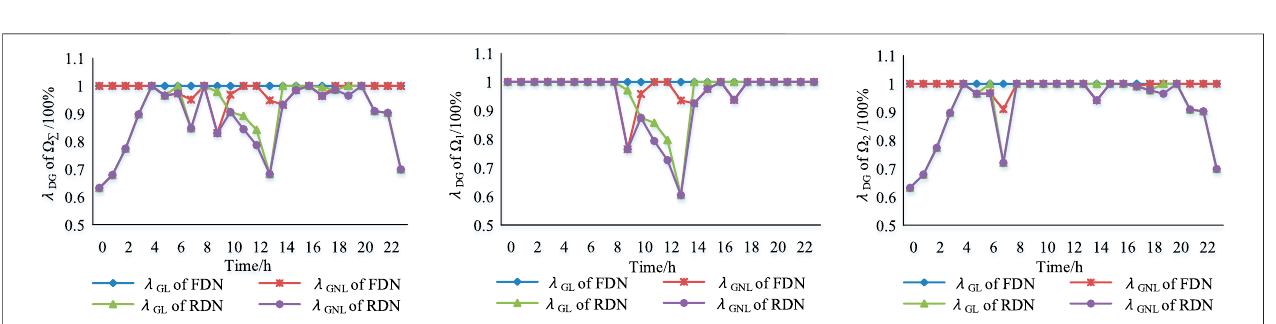
Frontiers in Energy Research |